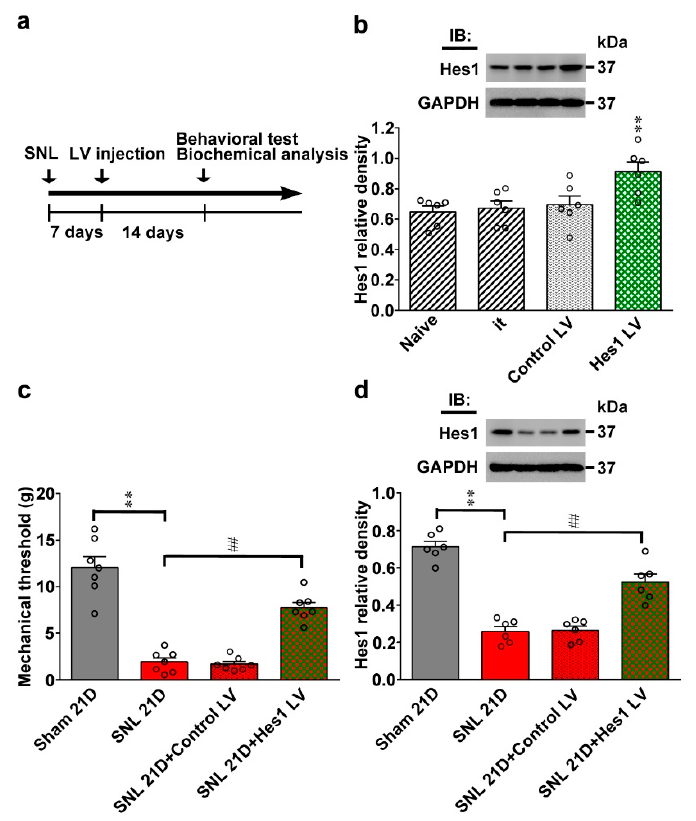
Figure 3. Lentiviral vector-mediated Hes1 expression reversed neuropathic allodynia. ( a ) Experimental timeline of spinal nerve ligation (SNL), lentiviral vector (LV) transfection, as well as behavioral test and biochemical analyses. Seven days after operation, lentivirus vector was spinally transfection. ( b ) Representative western blot and statistical analyses were performed (normalized to GAPDH). Transfecting naïve animals (Naïve) with the Hes1 ‐ encoding vector (Hes1 LV), but not with the control vector (Control LV) or implantation of the intrathecal catheter itself (it), increased the abundance of Hes1 in the dorsal horn sample. IB, immunoblotting. One ‐ way ANOVA, post ‐ hoc Tukey test, F(3,20) = 5.516, p = 0.0063. ** p < 0.01 vs. Naïve. n = 6. ( c ) Results of the von Frey test demonstrating that transfecting SNL animals with Hes1 ‐ encoding vector (SNL 21D + Hes1 LV), but not the control vector (SNL 21D + Control LV), ameliorated the SNL ‐ decreased withdrawal threshold in the ipsilateral hind paw tested at day 21 after operation. One ‐ way ANOVA, post ‐ hoc Tukey test, F